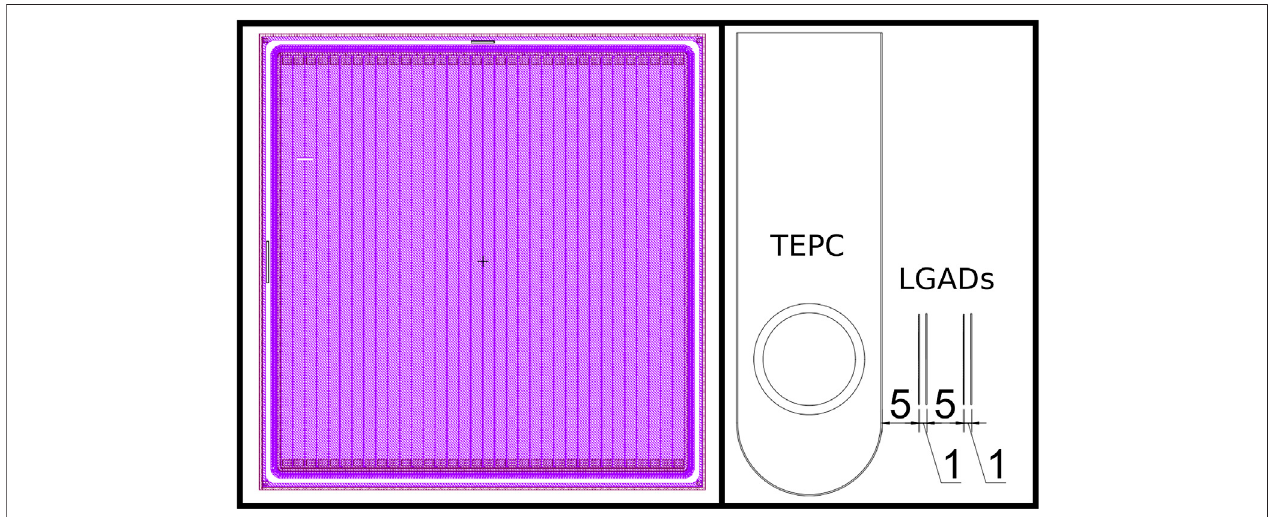
FIGURE1|Leftpanel: designofonelowgainavalanchediode(LGAD)sensorwith34activestrips. Rightpanel: Schemeofthehybriddetectorformicrodosimetry (HDM) setup, showing the tissue equivalent proportional counter (TEPC) followed by four LGAD layers. Distances between detectors are reported in millimeters.